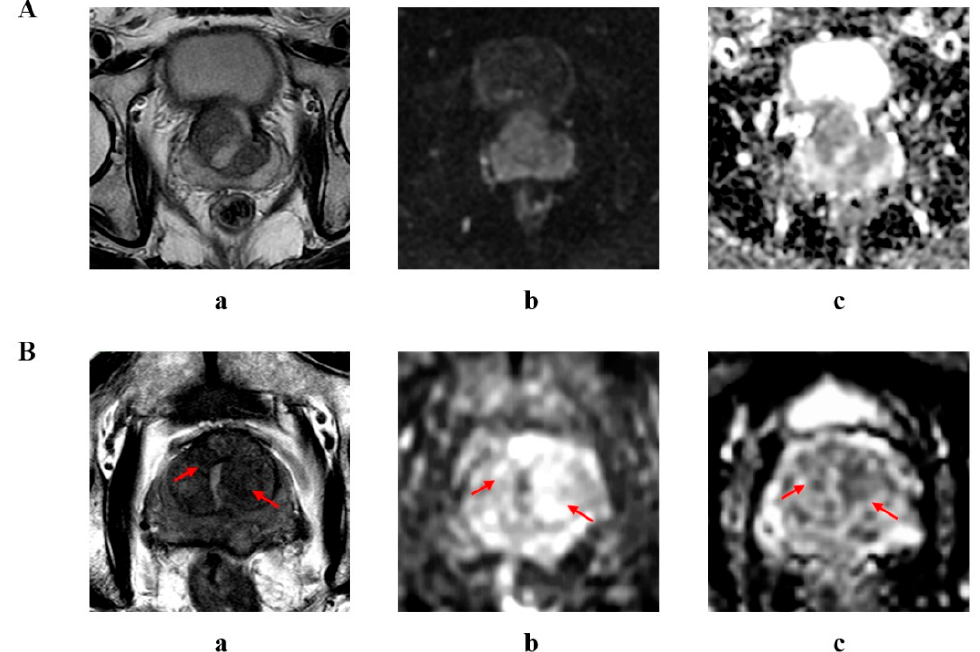
Figure 4. mpMRI results of two biopsy patients with TURP history. ( A ) A 63-year-old patient previously received TURP; no lesions with PI-RADS score ≥ 3 were found in TZ. Biopsy results showed CSPCa with a Gleason score of 4 + 3 = 7 in the TZ. ( B ). A 74-year-old patient previously received TURP; two lesions classified as PI-RADS score 4 were found in the bilateral TZ (arrow). Biopsy results were negative in the TZ. (a) T2-weighted image; (b) DWI with b-value of 1500 s/mm 2 ; (c) ADC map.